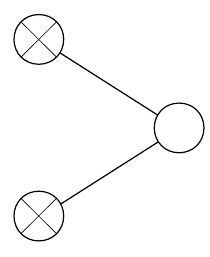
Figure 2 . The Dynkin diagram associated to the Bethe equations (5.19){(5.21): the central node corresponds to the momentum carrying variable (cid:18) , while the crossed nodes denote the fermionic nodes associated to the auxiliary variables (cid:12) 1 and (cid:12) 3